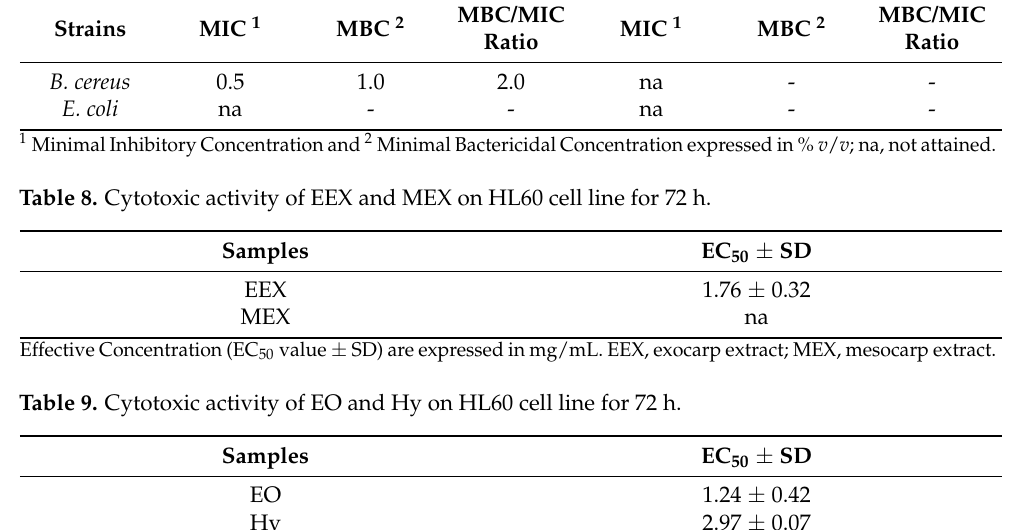
Table 7. Antibacterial activity of EO and HY. EO Hy Strains MIC 1 MBC 2